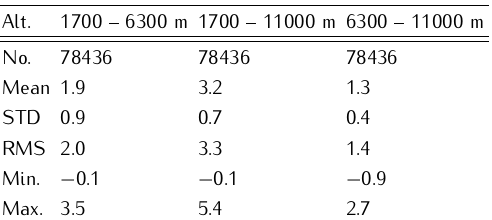
Figure 3. Residual gravity anomalies along the track T108 and T811. Table 4. Statistics of inter-comparisons at alt. 11000 m. Units in mGal.